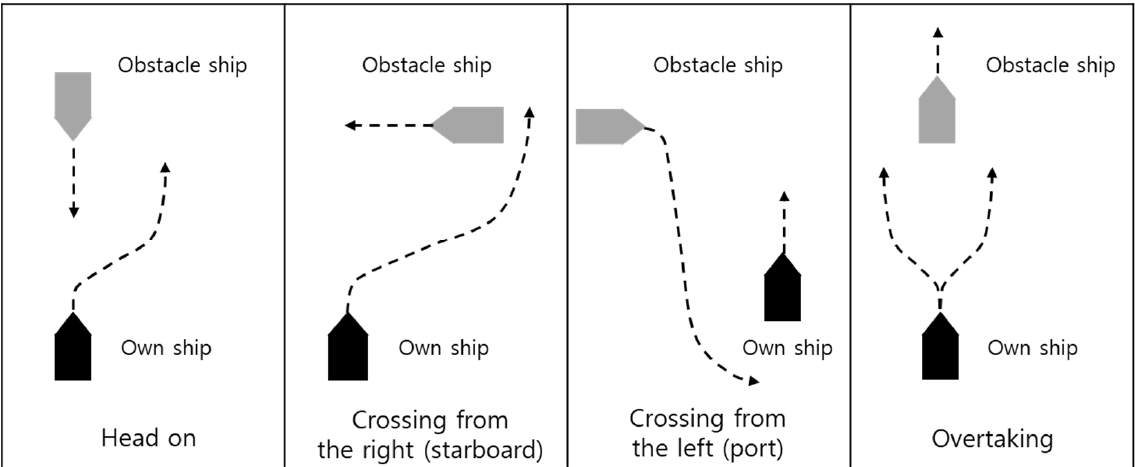
Figure 2. Main COLREG scenarios (the keywords in [10] was used; the composition and meaning of the picture are similar to [11,12]).